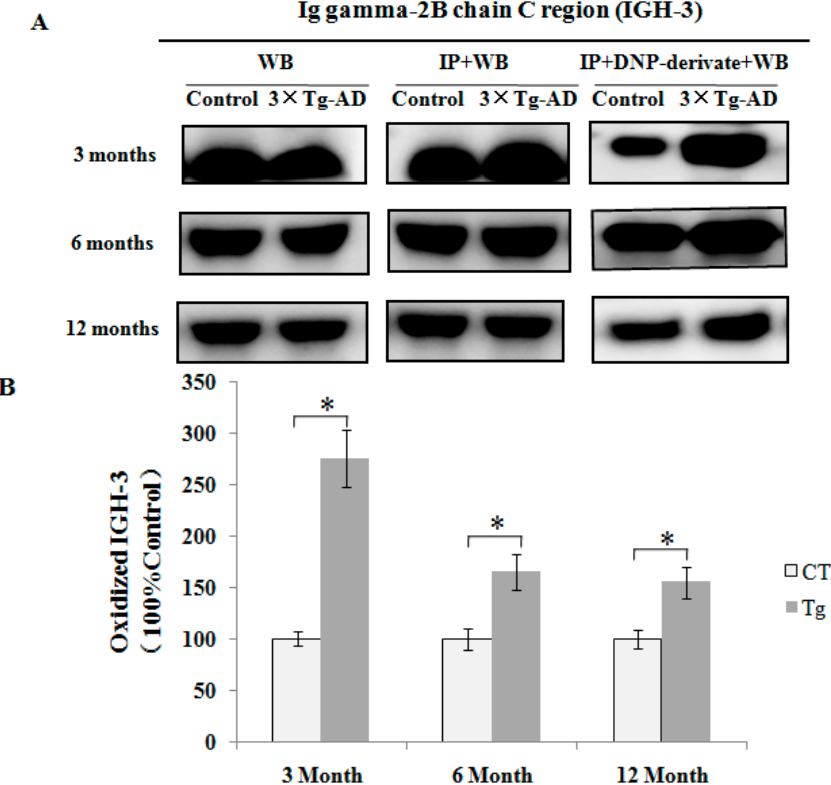
Figure 6. Immunoprecipitation followed by Western blot analysis was performed to confirm the carbonylation of IGH-3 proteins in serum. ( A ) The expression level of the protein was detected with anti-IGH-3 (WB). The efficiency of immunoprecipitation was checked with anti-IGH-3 (IP + WB). The protein was immunoprecipitated with its antibody and Western blot analysis with anti-DNP antibody (IP + DNP-derivate + WB); ( B ) Histograms shows the alteration of protein carbonylated levels, in which the measured value is normalized with the mean of the control subjects ( n = 3). * p < 0.05 vs. the control.